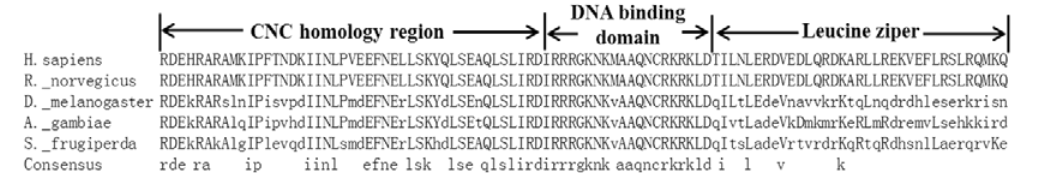
Figure 3. Homology and similarity between nuclear factor erythroid 2 related factor 2 (Nrf2), Cnc isoform C (CncC), and the known members of the NF-E2 family. The conserved regions among the NF-E2 family members are shown in detail. The alignment covers the leucine zipper, the DNA binding domain, and the Cnc homology region immediately N-terminal to the DNA binding domain. Uppercase